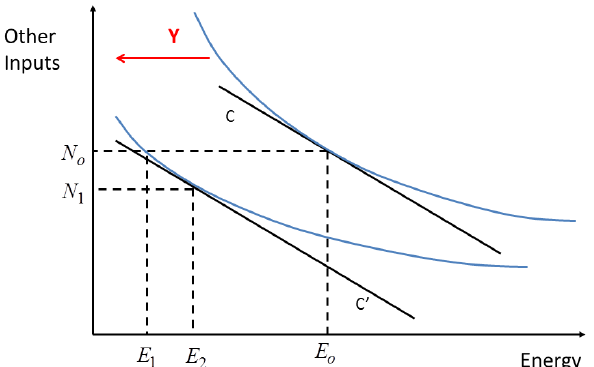
Figure 2. Energy-augmenting technical change encourages the substitution of energy for other